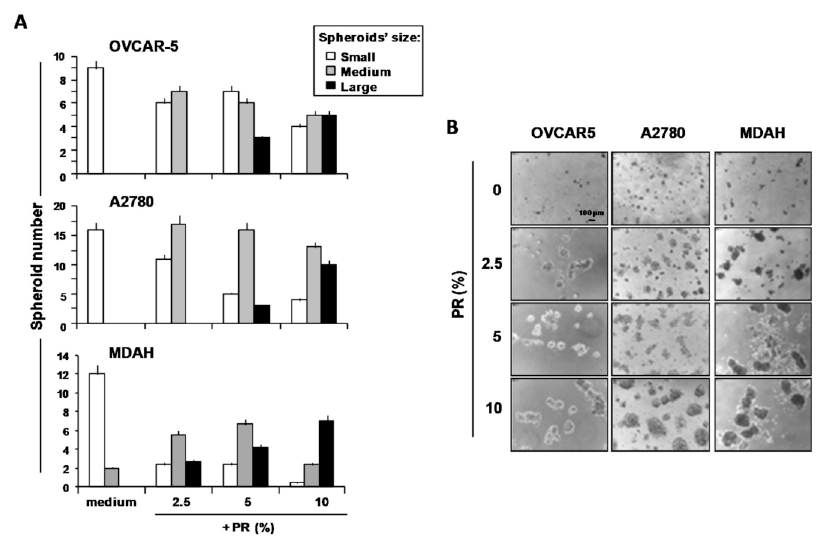
Figure 1. Human platelet releasate (PR) increased spheroid formation in OVCAR5, A2780 and MDAH cells. Cells were cultured on poly-HEMA-coated plates with or without increasing concentrations of PR pools. ( A ) After 5 days, images were captured using an inverted microscope and spheroids were counted (number of cells/spheroid: 2–5 = small; 6–20 = medium; >20 = large). Data are expressed as mean ± SEM of three replicates with three different PR pools. ( B ) Representative phase- contrast photomicrographs (original magnification 4 × ) showing the formation of ovarian cancer (OvCa) cell multicellular tumor spheroids (MCTSs) in the presence of various PR concentrations.